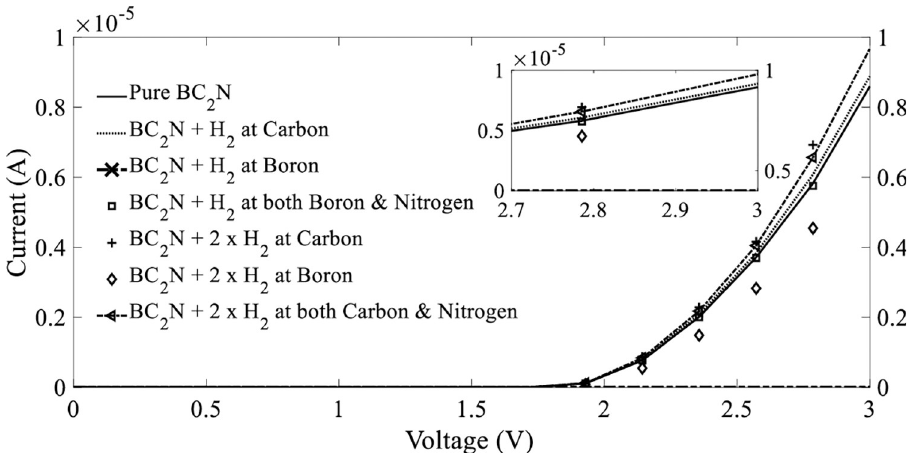
Fig 16. Current–voltage (I–V) characteristics before and after the adsorption of H 2 gas molecules on BC 2 N at a temperature of 1000